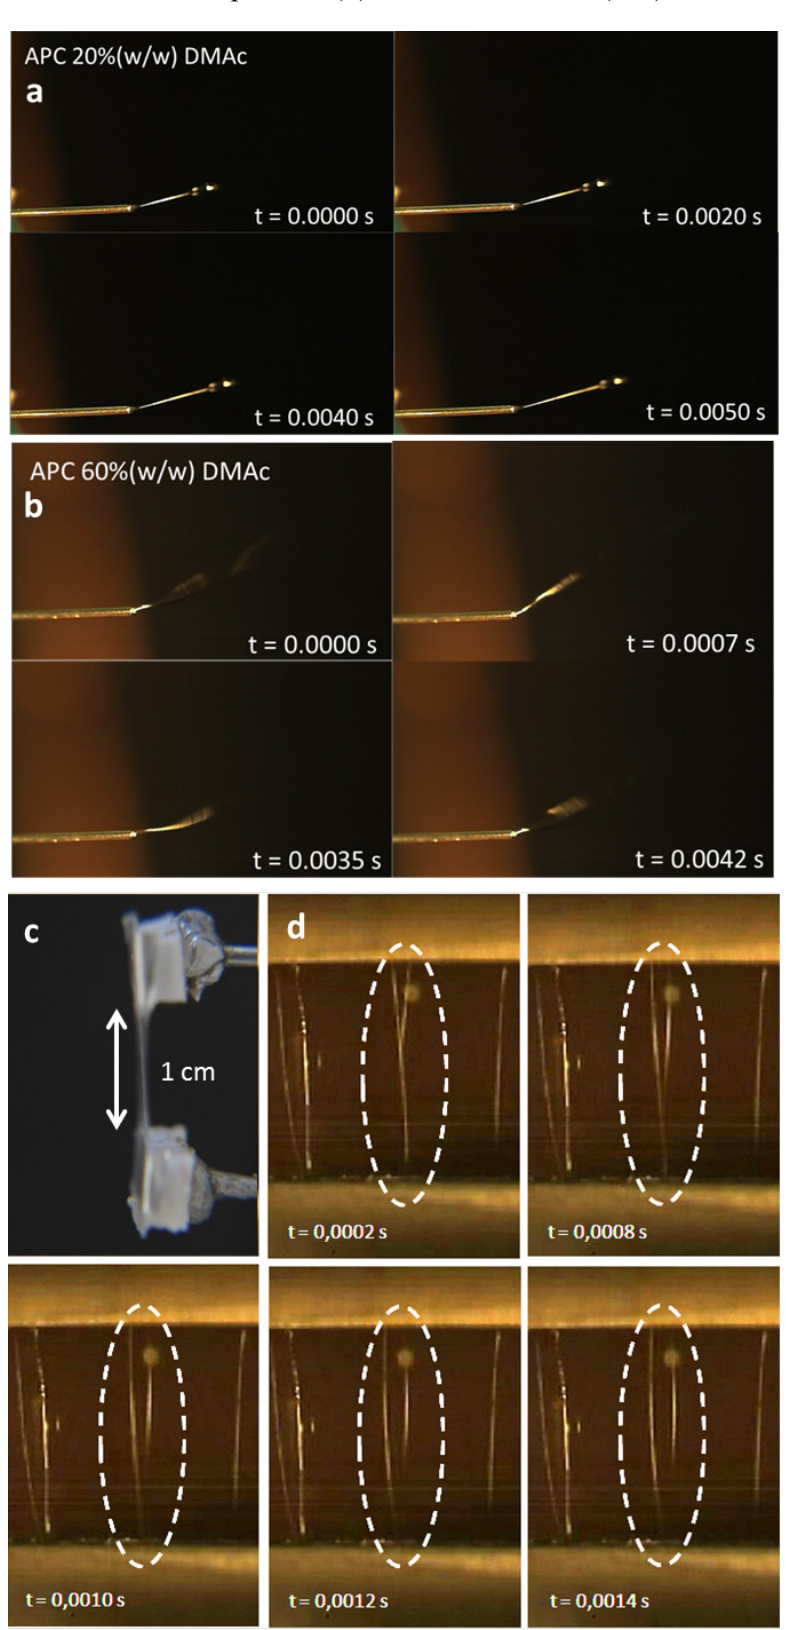
Figure 3. Frames were taken form a movie of the tip’s needle during electrospinning of an isotropic ( a ) (Figure S1) and a liquid crystal ( b ) (Figure S2) solution; ( c ) split electrode target, a gap of 1 cm and fiber deposition ( d ) and characteristics ( e – h ) as a function of